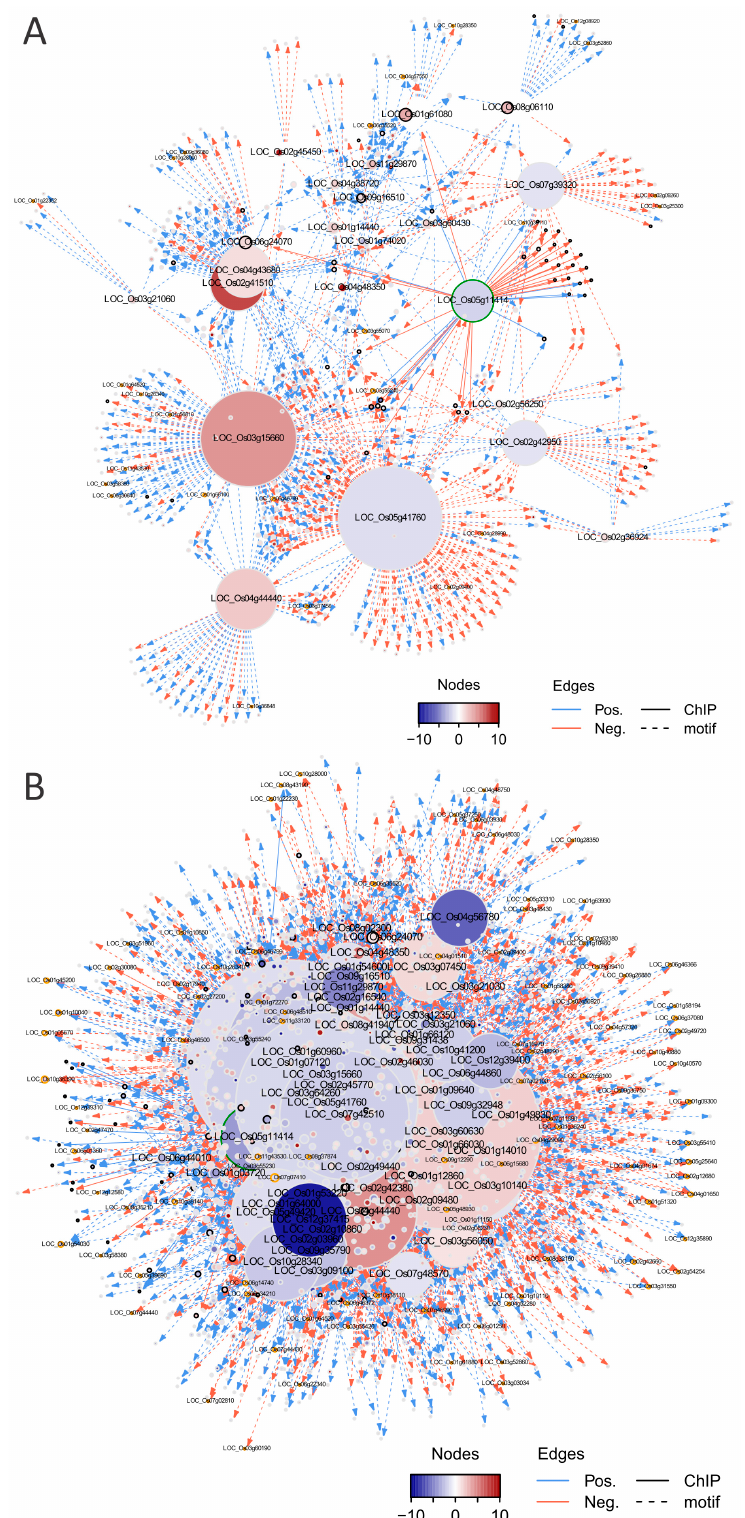
Figure 10. Transcriptional regulatory networks related to multiple pathways. Only the upstream and downstream genes of pathway-related genes differentially expressed in the WT-dSpm ( A ) and WT-CRISPR ( B ) comparison are shown. High quality original files of A and B can be found in the Supplementary